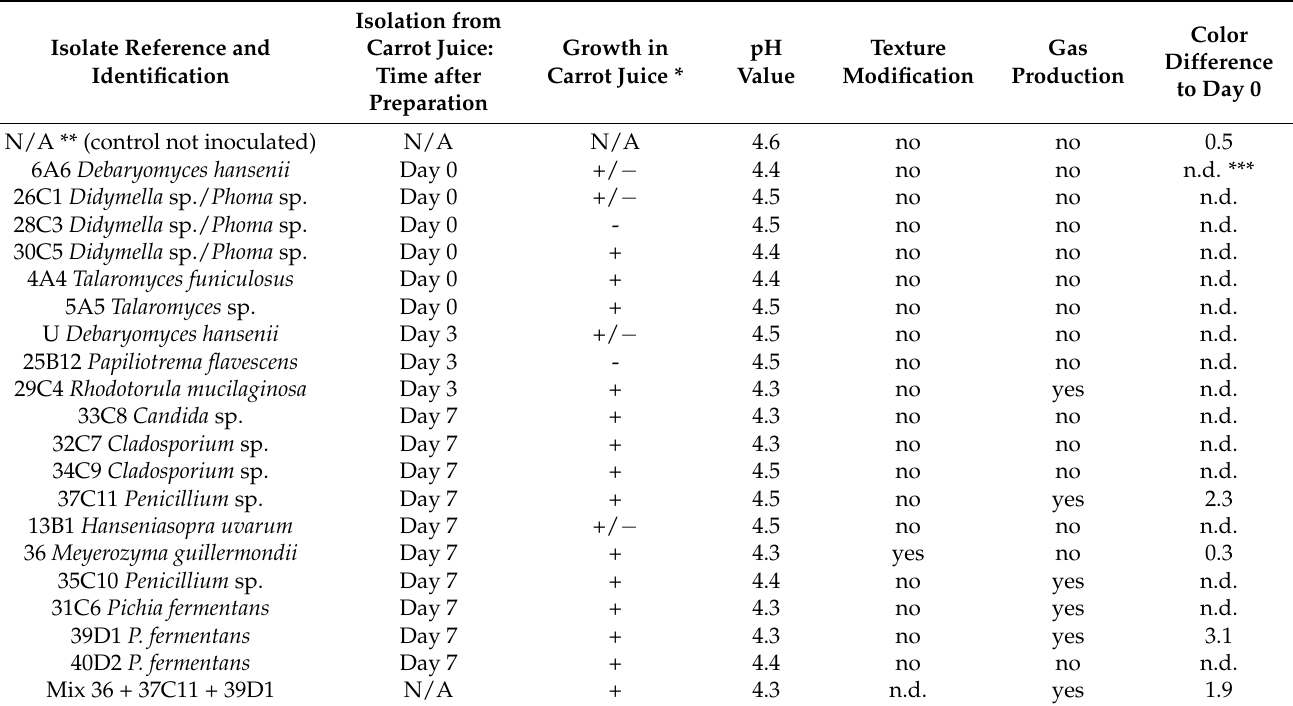
Table 4. Origin of fungal isolates, identification and effects on carrot juice after 7 days of storage at 4 ◦